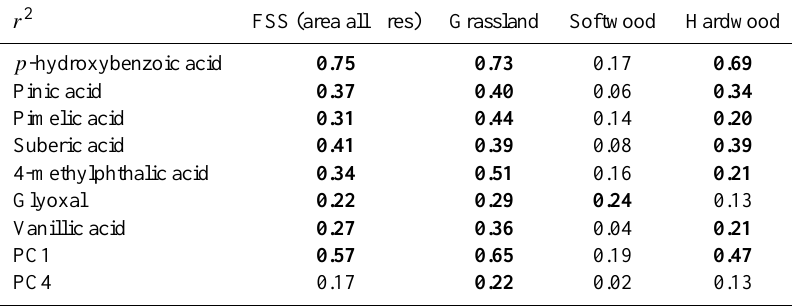
Table 4. Coefficients of determination ( r 2 ) for compounds and components linked to biomass burning ( r 2 , significant at the 0.05 level marked in